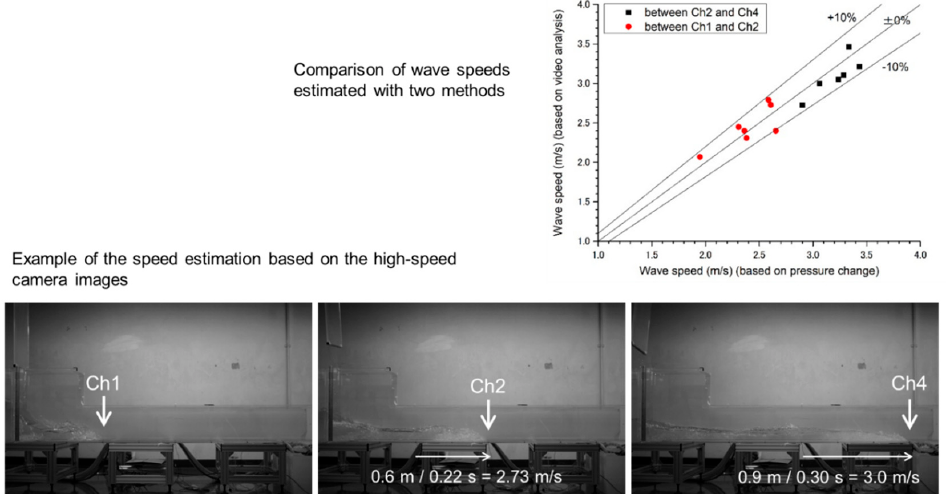
Figure A5. Wave speed estimation based on the pressure measured by the sensors vs that based on video analysis.